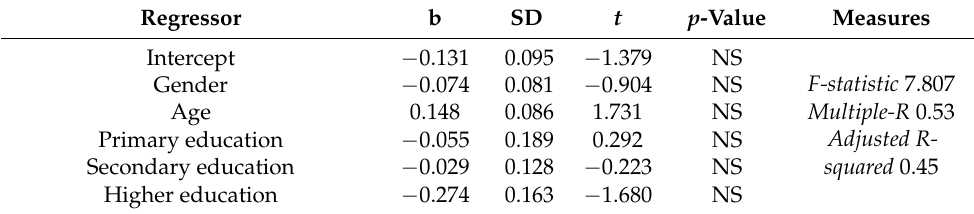
Table 4. Multivariate linear regression analysis with internalized stigma total score as an indepen- dent